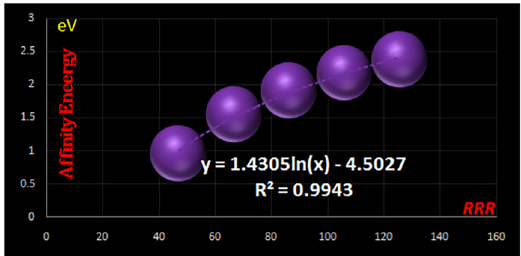
Figure 3. Electron Affinity Energy changes in Circumacenes family according to RRR index.